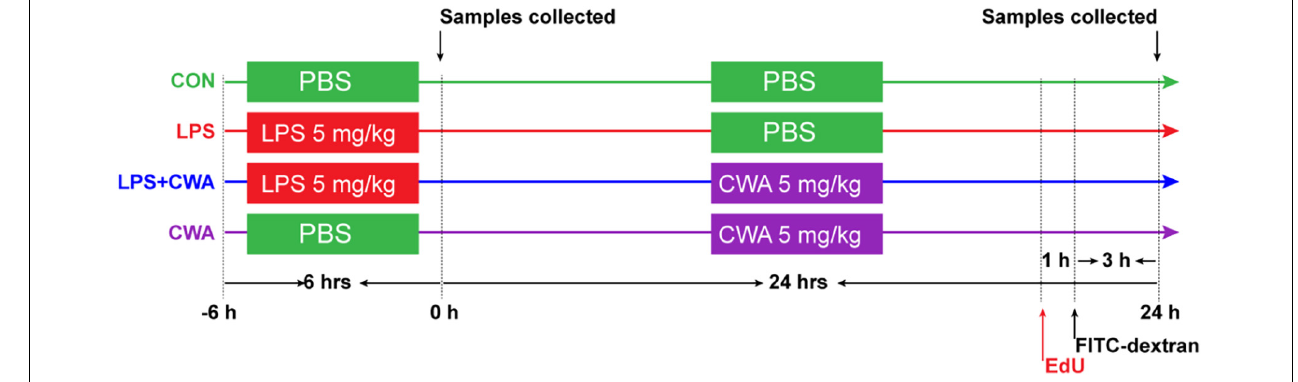
FIGURE 1 | Experimental design and scheme of the animal